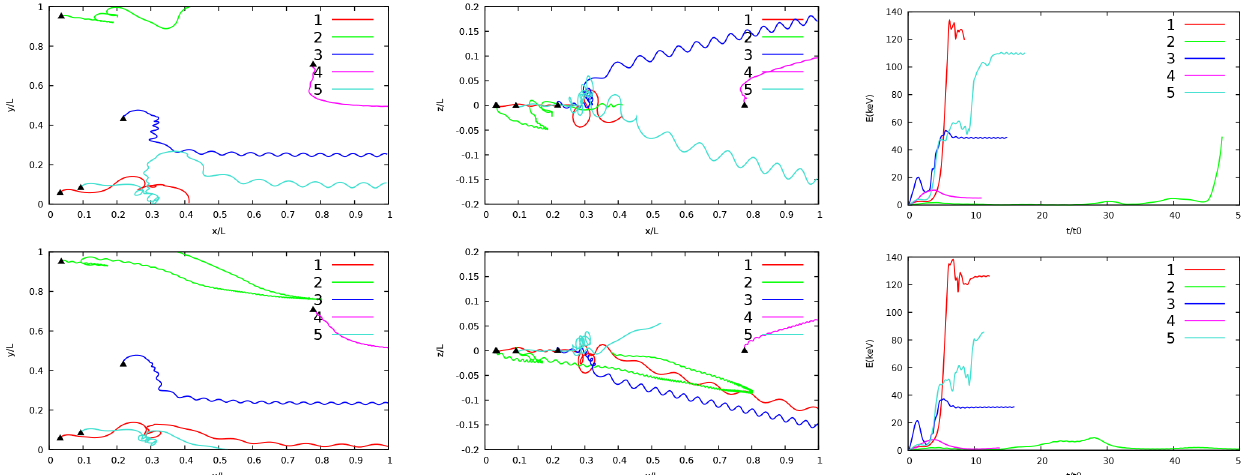
Figure 3. Trajectories and kinetic energies of protons in the presence of B x (z) as in profile 1 (upper panels) and as in profile 2 (lower panels). The fluctuation level is set to A 0 /(cid:96) = 10nT. The colored lines represent the particle orbits and their starting points are denoted by triangles. Axes not to scale. Particles are injected at t = 0 randomly within the (x,y) plane and at z = 0. Their initial velocities are extracted from the same Maxwellian distribution (see text for further details).